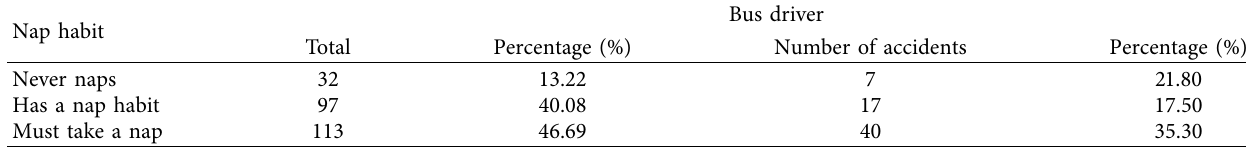
Table 9: Distribution of nap habits.